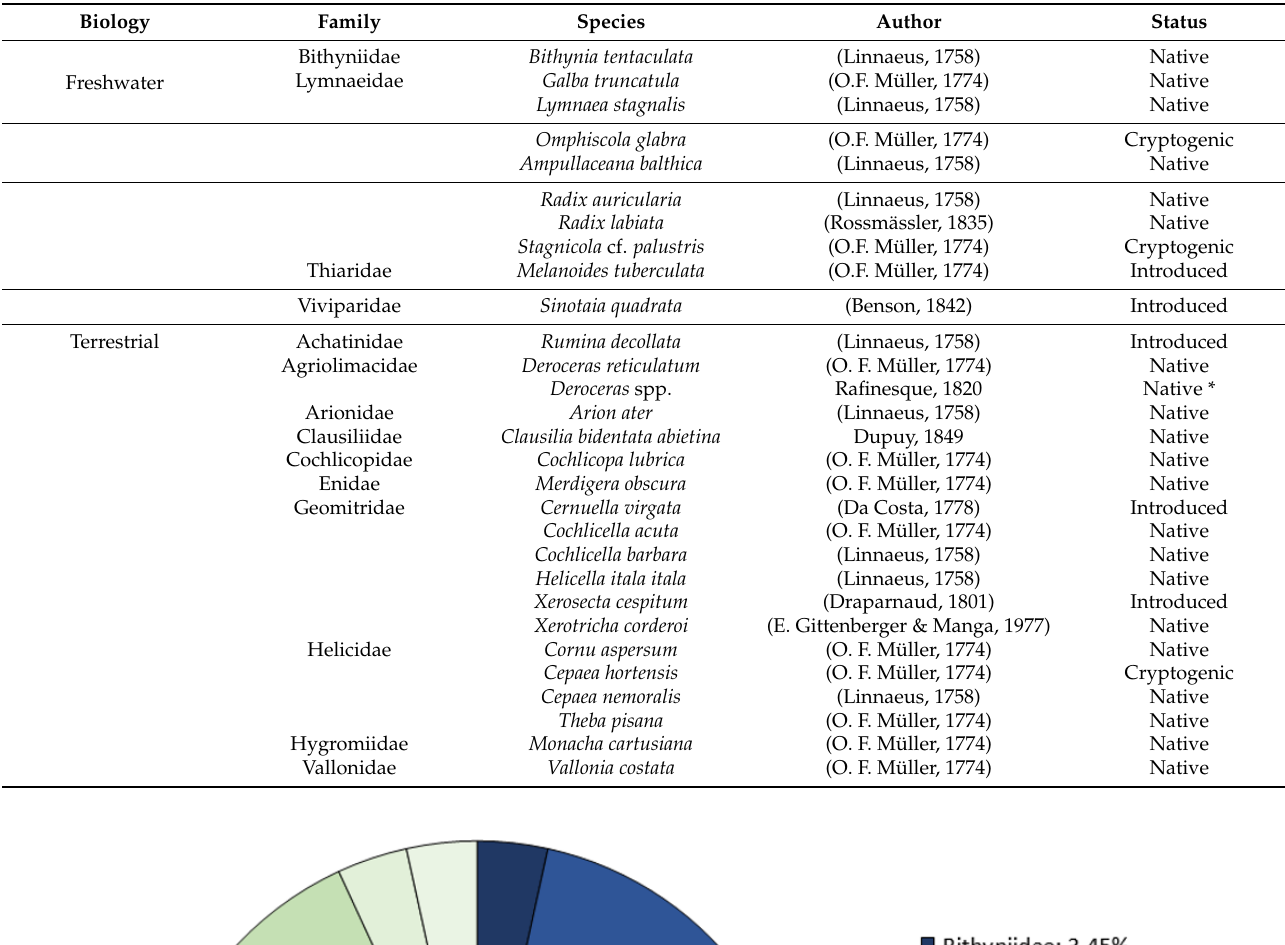
Table 2. Diversity of mollusc hosts of digenean trematodes that can parasitise humans. * The status of genus Deroceras depends on the specific species.